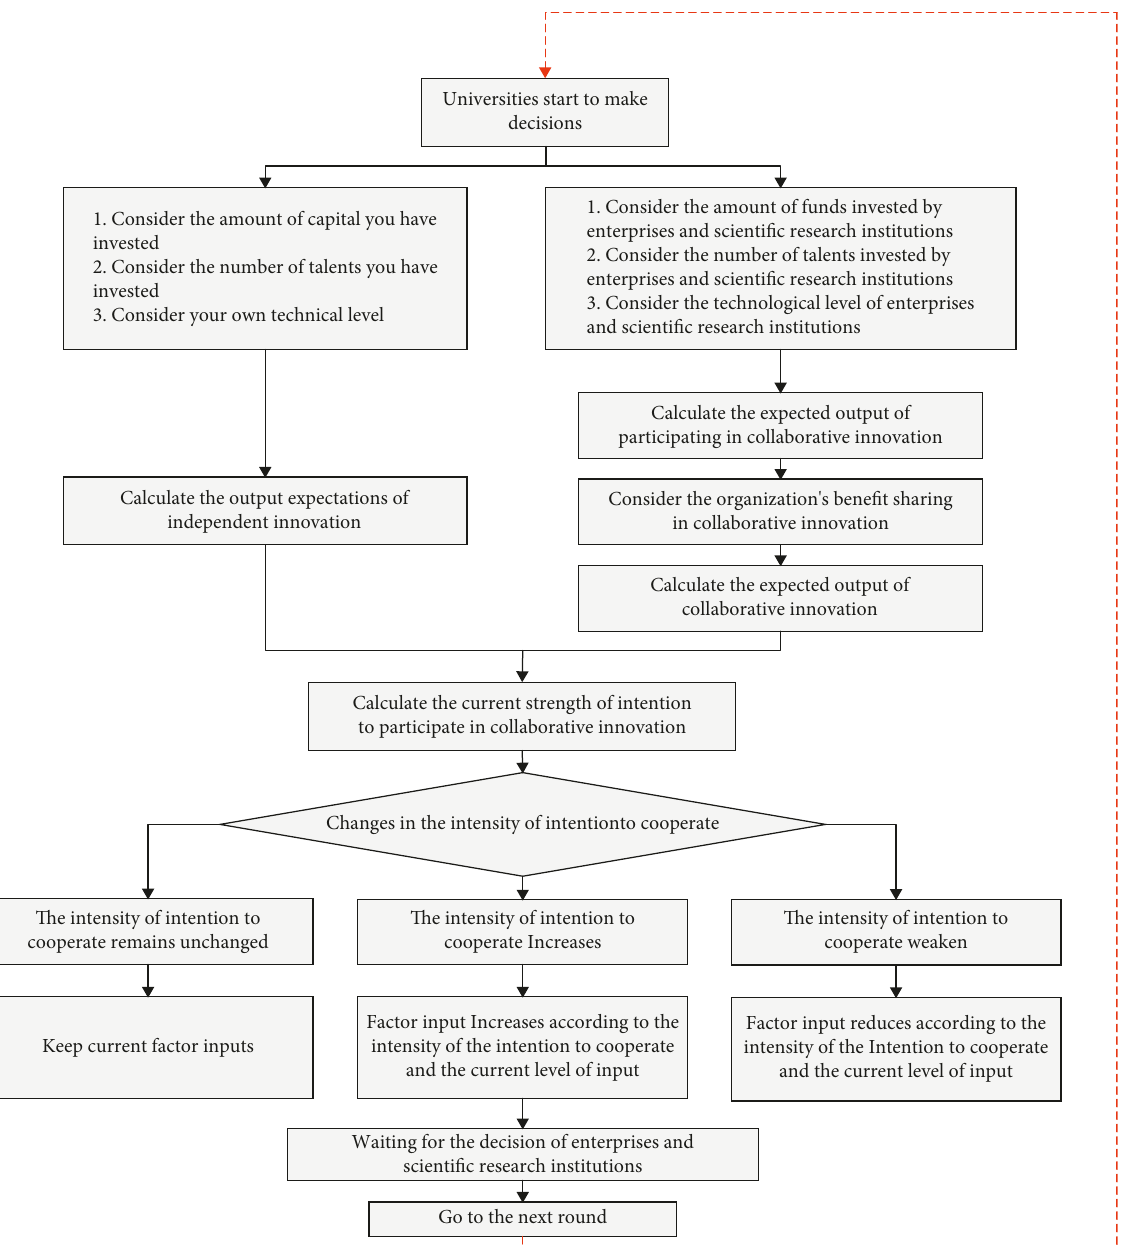
Figure 2: Logic diagram of universities behaviour